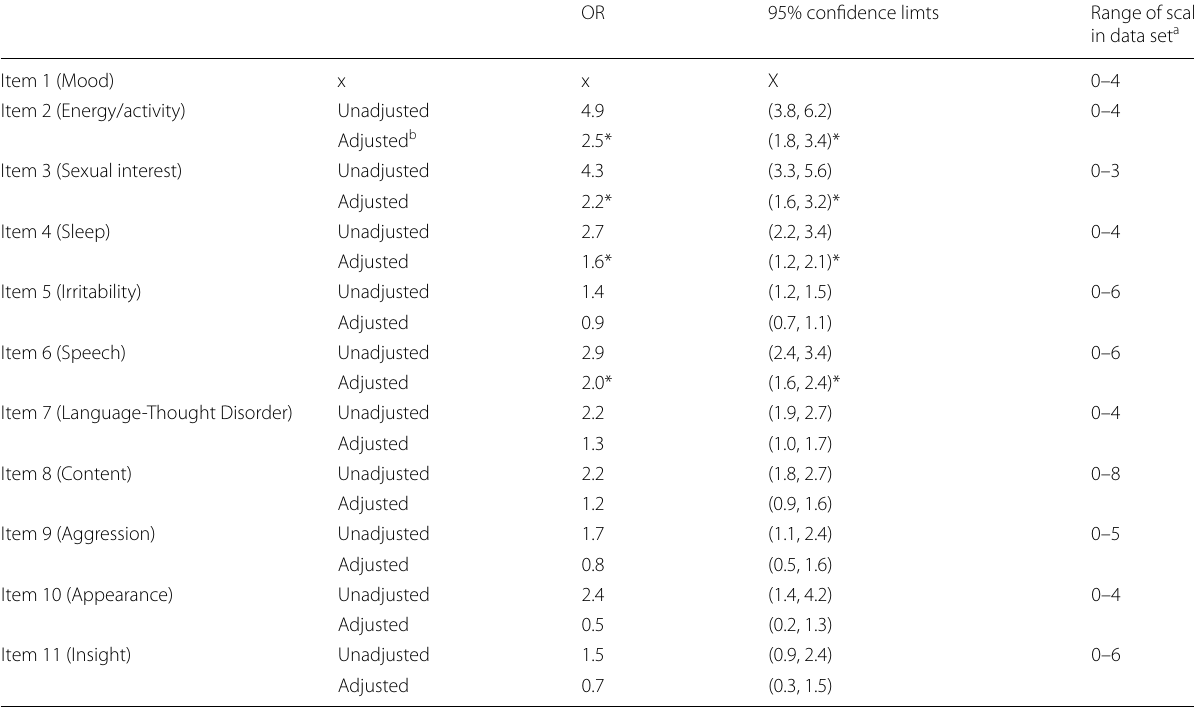
Table 4 Odds ratios of experiencing elevated mood depending on the different manic symptoms (YMRS items) during 849